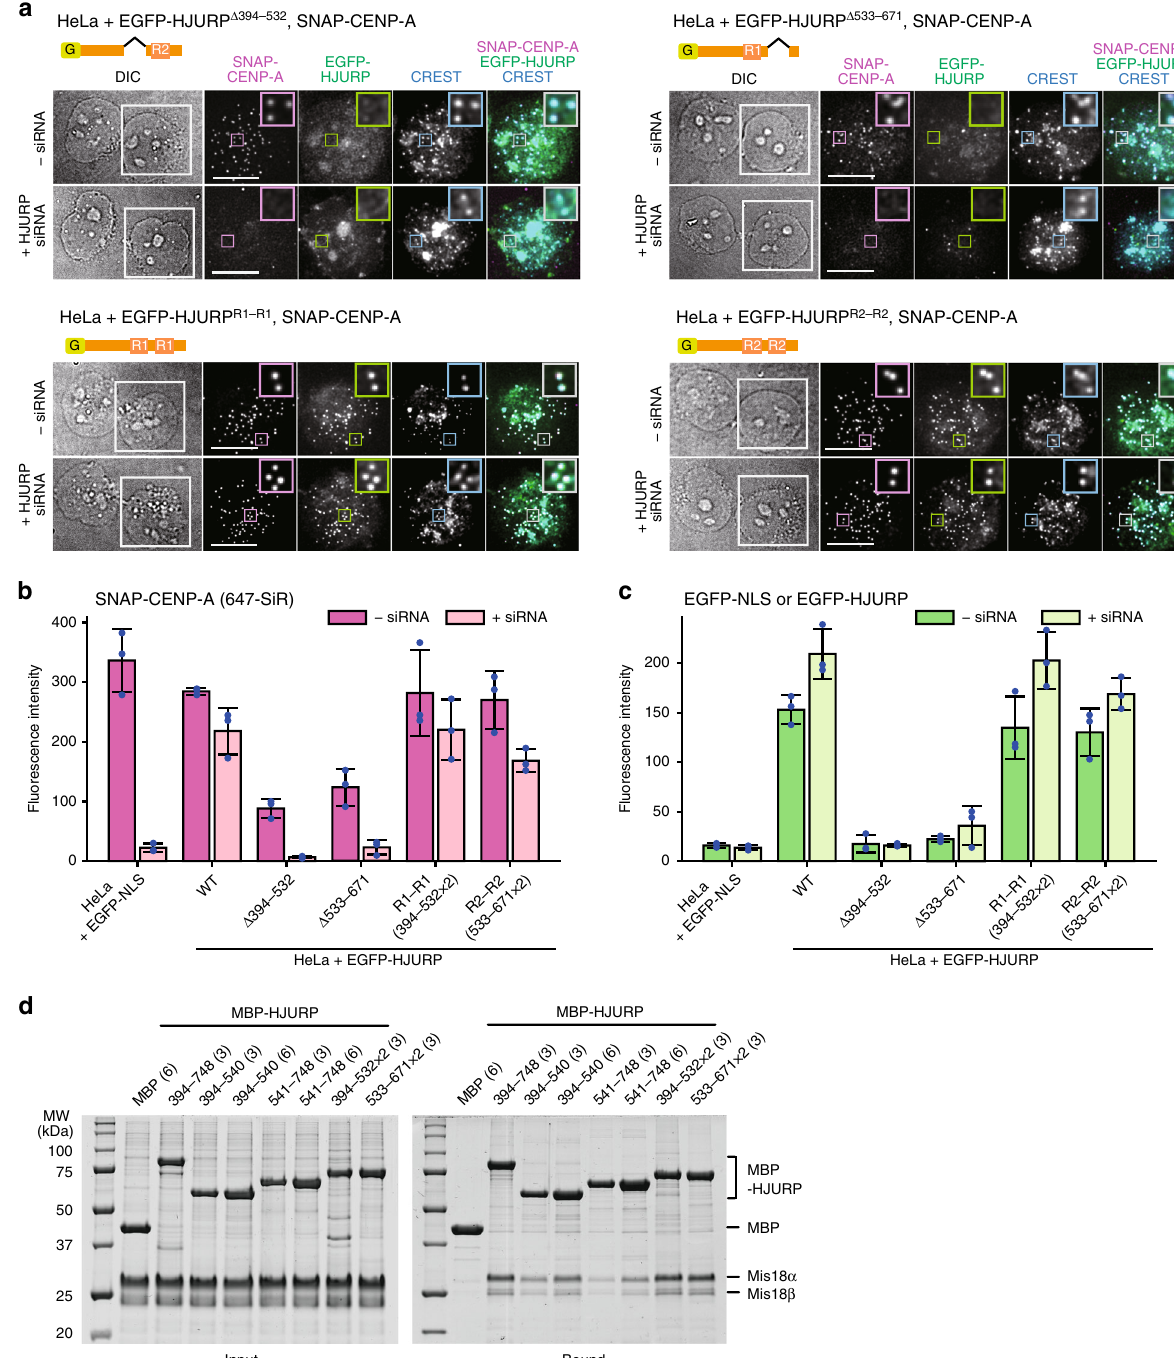
Fig. 3 Tandem repeats of HJURP R1 or R2 rescue the localization of HJURP and CENP-A deposition. a Representative images showing the fl uorescence of SNAP-CENP-A and EGFP-HJURP variants in fi xed HeLa cells treated as described in Fig. 2a. White scale bars indicate 10 µ m. b , c Quanti fi cation of the centromere fl uorescence intensity of SNAP-CENP-A or EGFP-HJURP variants. The bar graphs represent mean values from three replicate experiments (blue dots indicate the mean values from each experiment). Error bars indicate standard deviations. d SDS-PAGE results of amylose-resin pull-down assays showing the increase of HJURP binding to Mis18 core when tandem repeats of R1 and R2 were used. The numbers in the parenthesis indicate the concentrations ( µ M) of the proteins used in the assays. Source data are provided as a Source Data fi